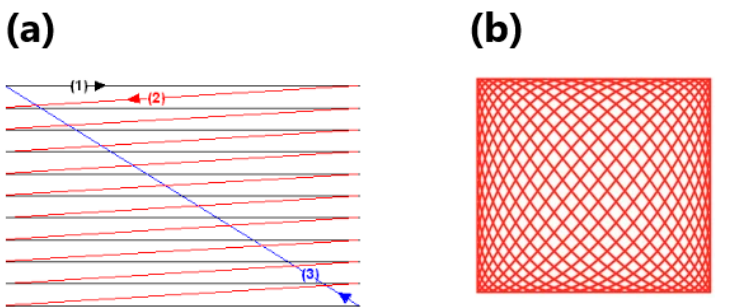
Figure 4. Principle of main scanning techniques: ( a ) raster scanning and ( b ) Lissajous scanning.